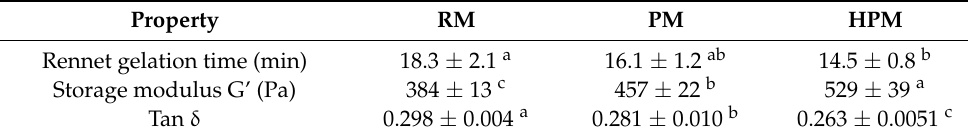
Table 6. Rennet gelation properties of differently processed deer milks